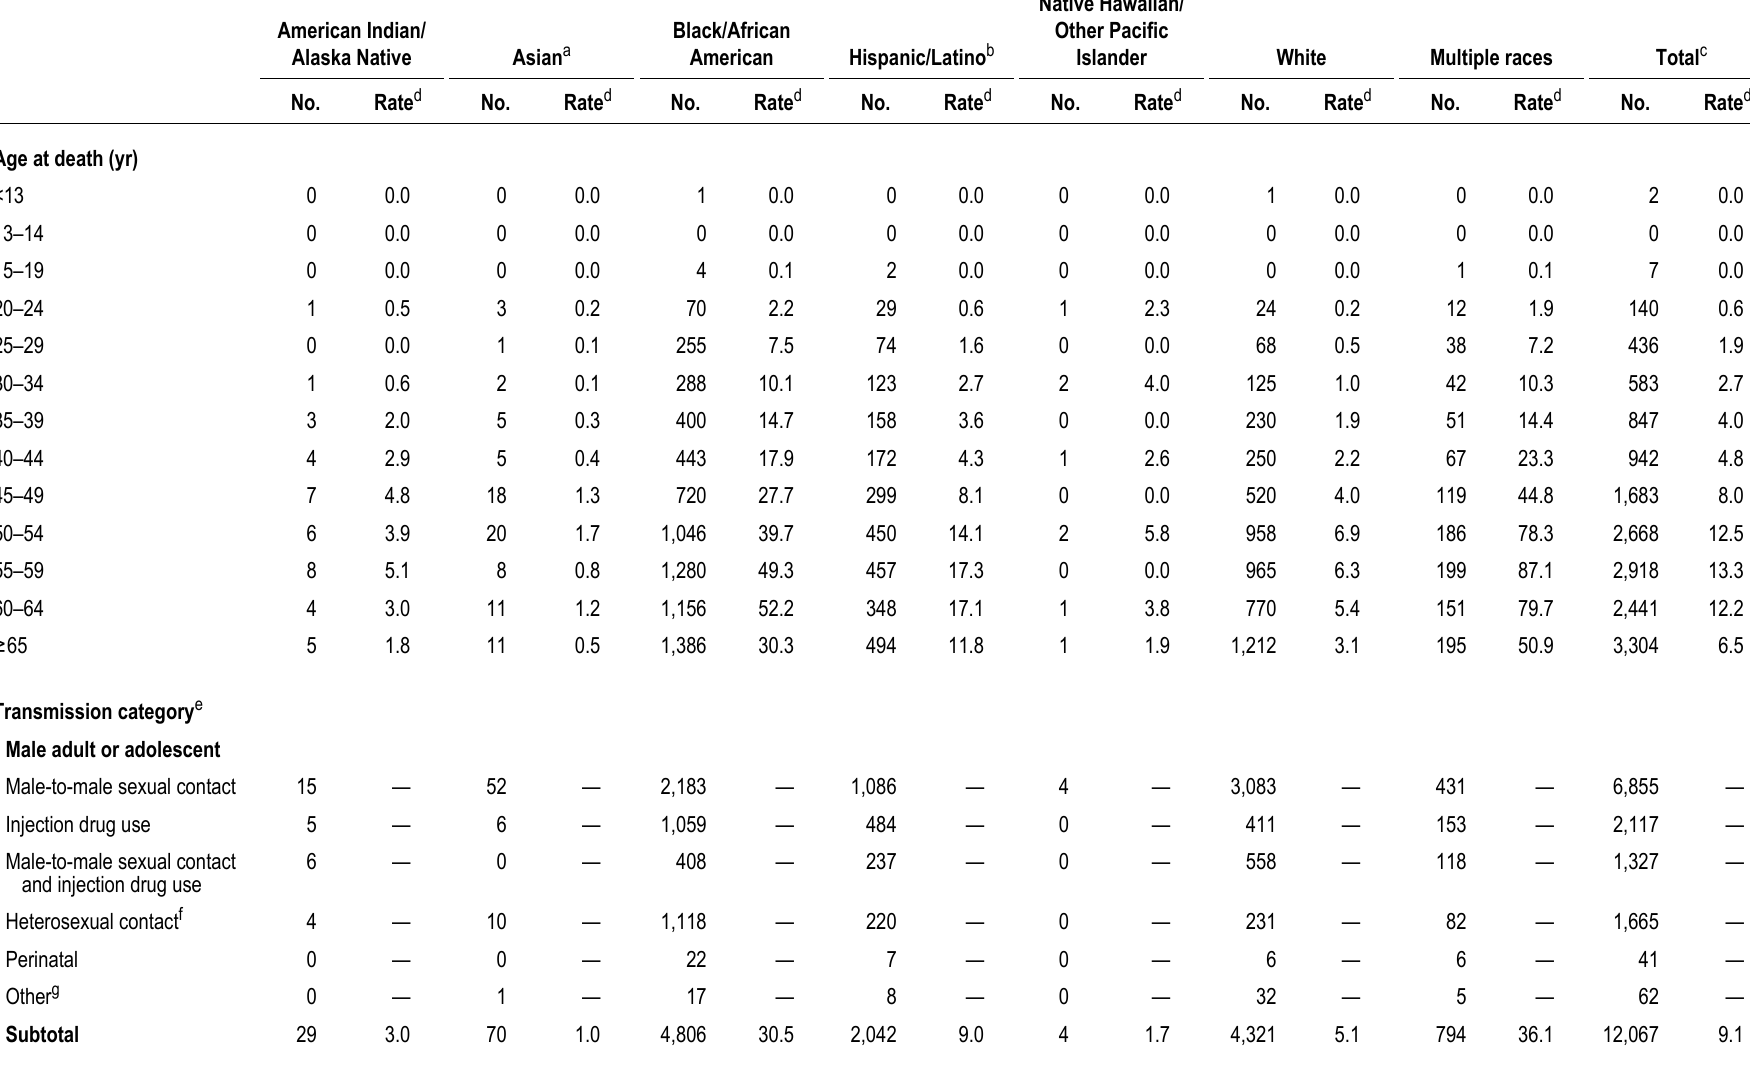
Native Hawaiian/ Other